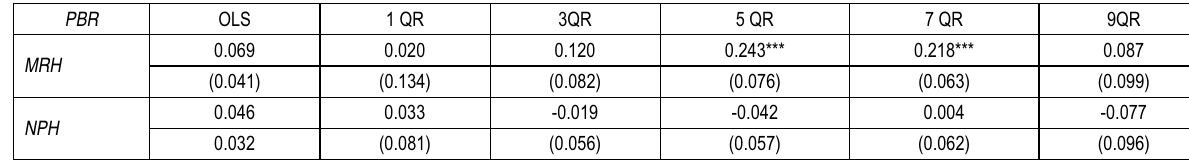
Table 6. The results of quantile regression on P/B ratio ( PBR